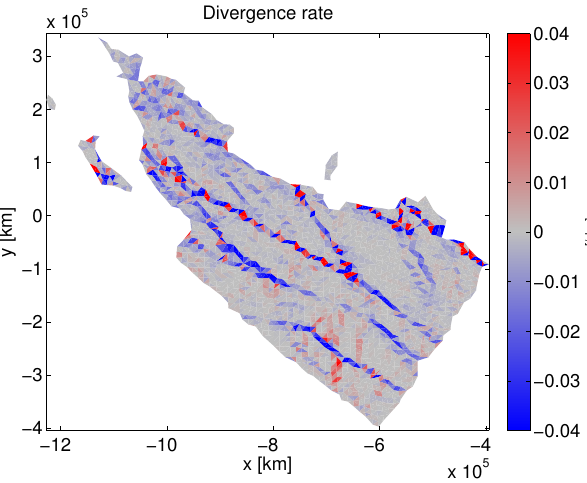
Figure 4. Unfiltered divergence rate computed from the RGPS sea ice trajectory data set and corresponding to the pair of images taken at t k − 1 = 3 February 2007 at 17:44:00UTC and t k = 7 Febru- ary 2007 at